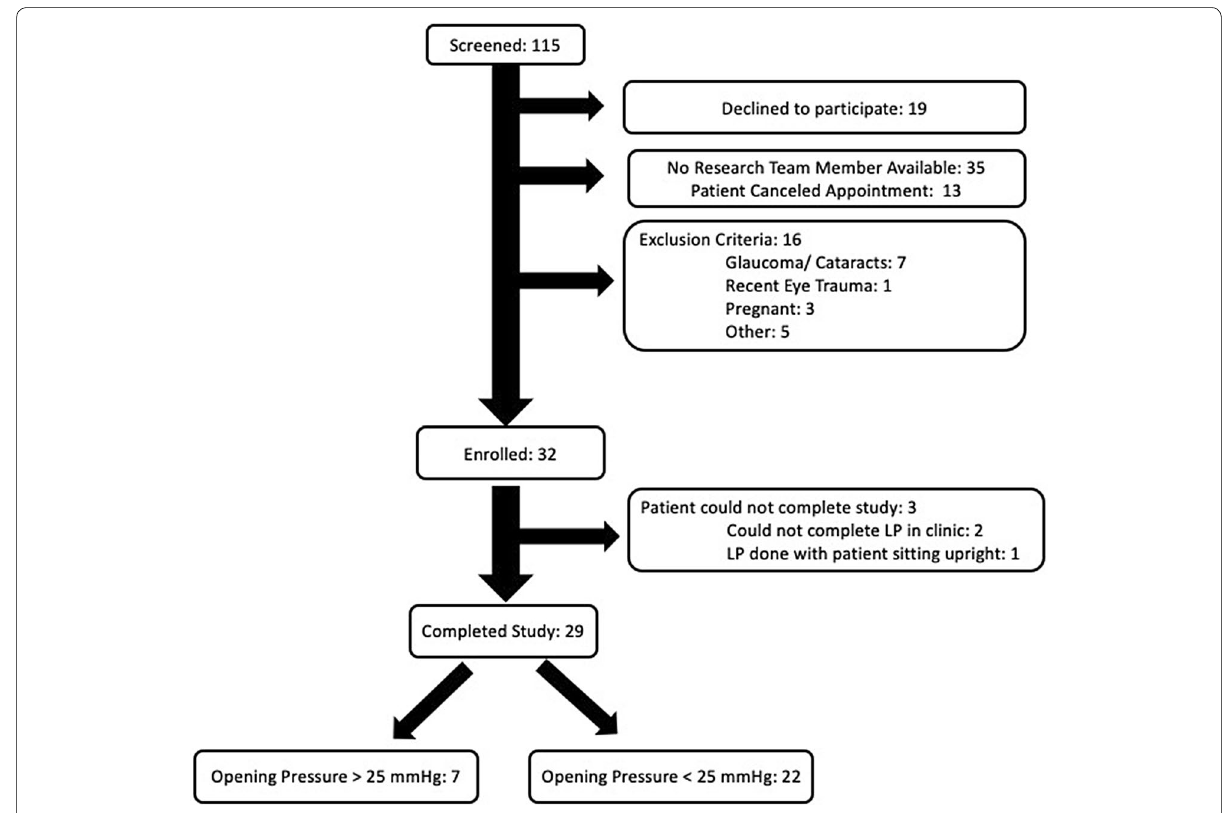
Fig. 1 Patient enrollment flow chart. LP lumbar